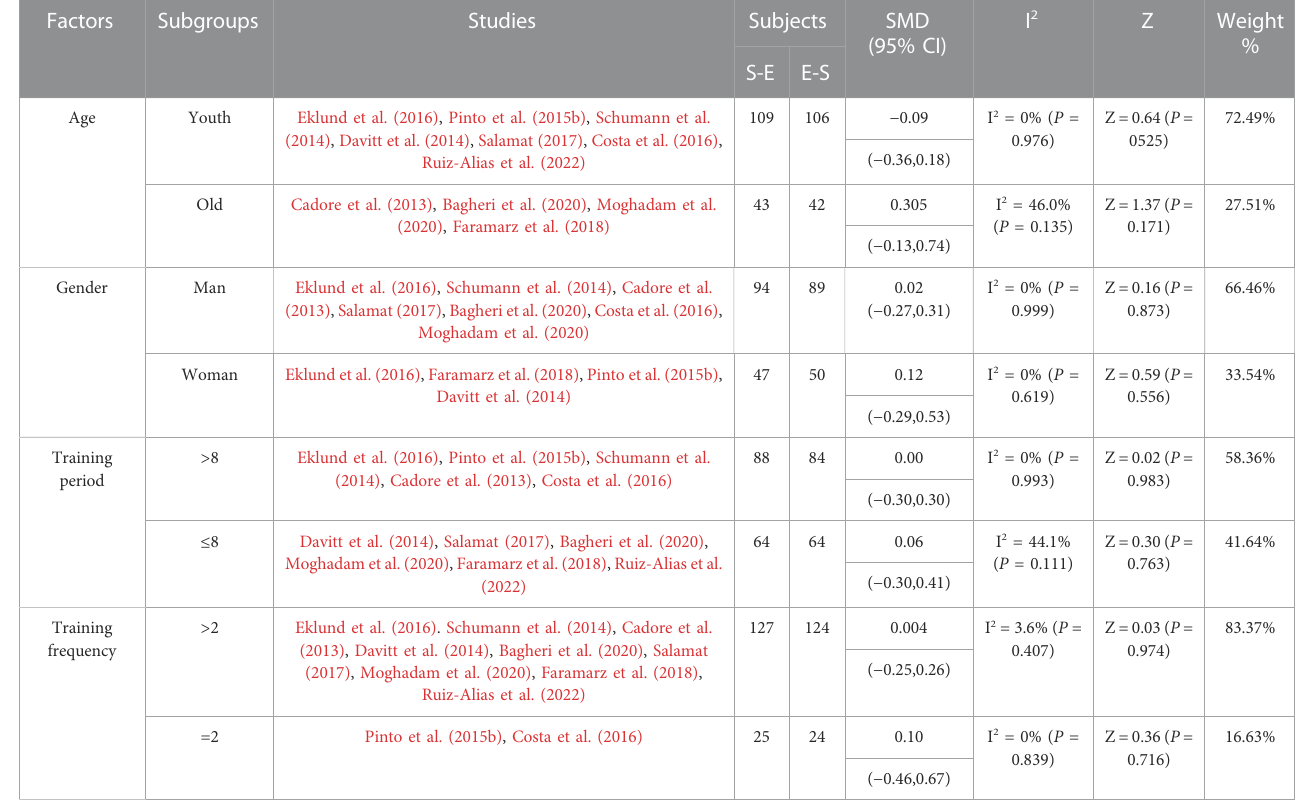
TABLE 3 Subgroup analysis of the impact of concurrent training sequence on VO 2max .